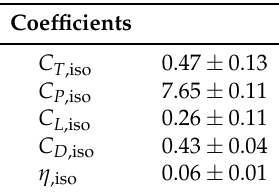
Table 2. Time-averaged net thrust, power, lift and drag coefficients, as well as propulsive efficiency of an isolated hydrofoil at St = 0.8 and k = 3.1. ± ( · ) represents the standard deviation calculated from 10 experimental